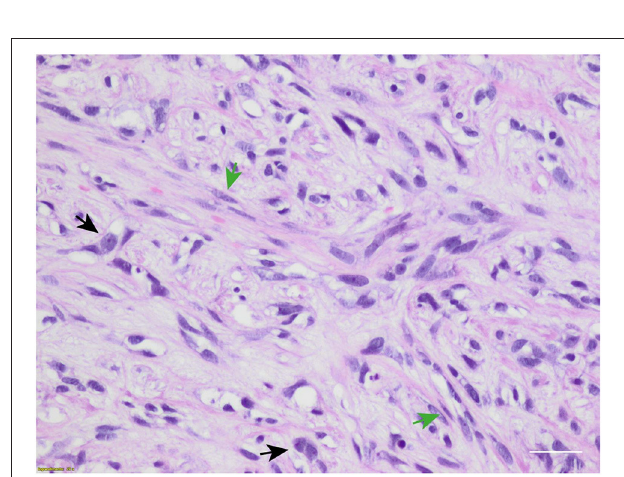
FIGURE 2 | Microscopic hematoxylin and eosin photograph of metaplastic breast carcinoma (MpBC) with coexisting spindled (green arrows) and oval (black arrows) cells. Scale bar: 50 µ